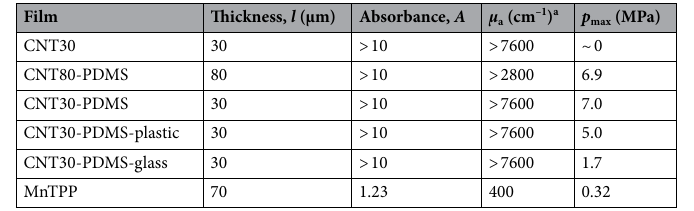
Table 1. Properties of piezophotonic films. At 532 nm for a laser fluence of 50 mJ/cm 2 . a Napierian absorption coefficient, µ a = 2.3 A /